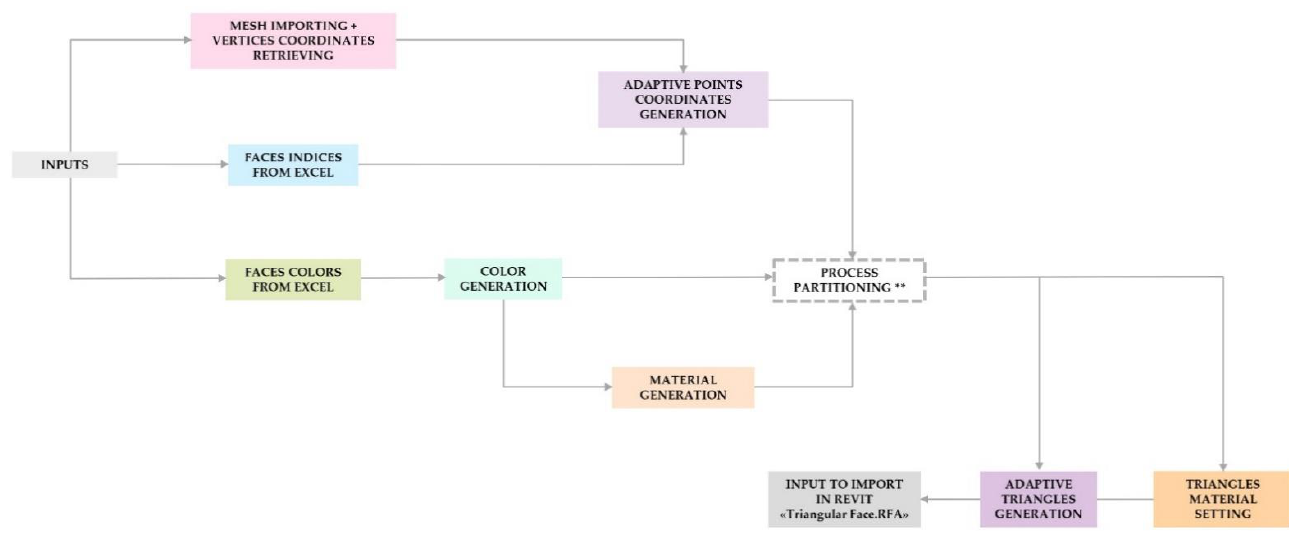
Figure 3. Workflow B: Visual Programming Language (VPL) script to parametrise the mesh into Revit. (PROCESS PARTITIONING **: refers to the choice of partitioning the script in Figure 11 by repeating the last two steps — Figure 11d — up to eight times in order to monitor the process and for the hardware to run it efficiently).